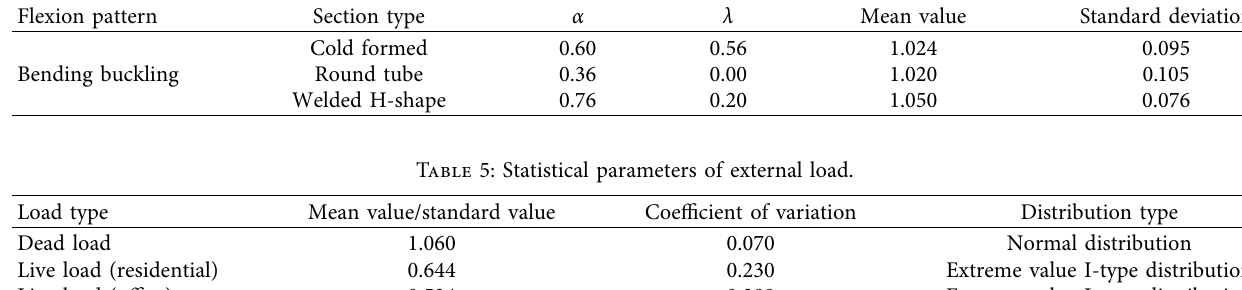
Table 4: Values of parameters for proposed curves and comparison results.